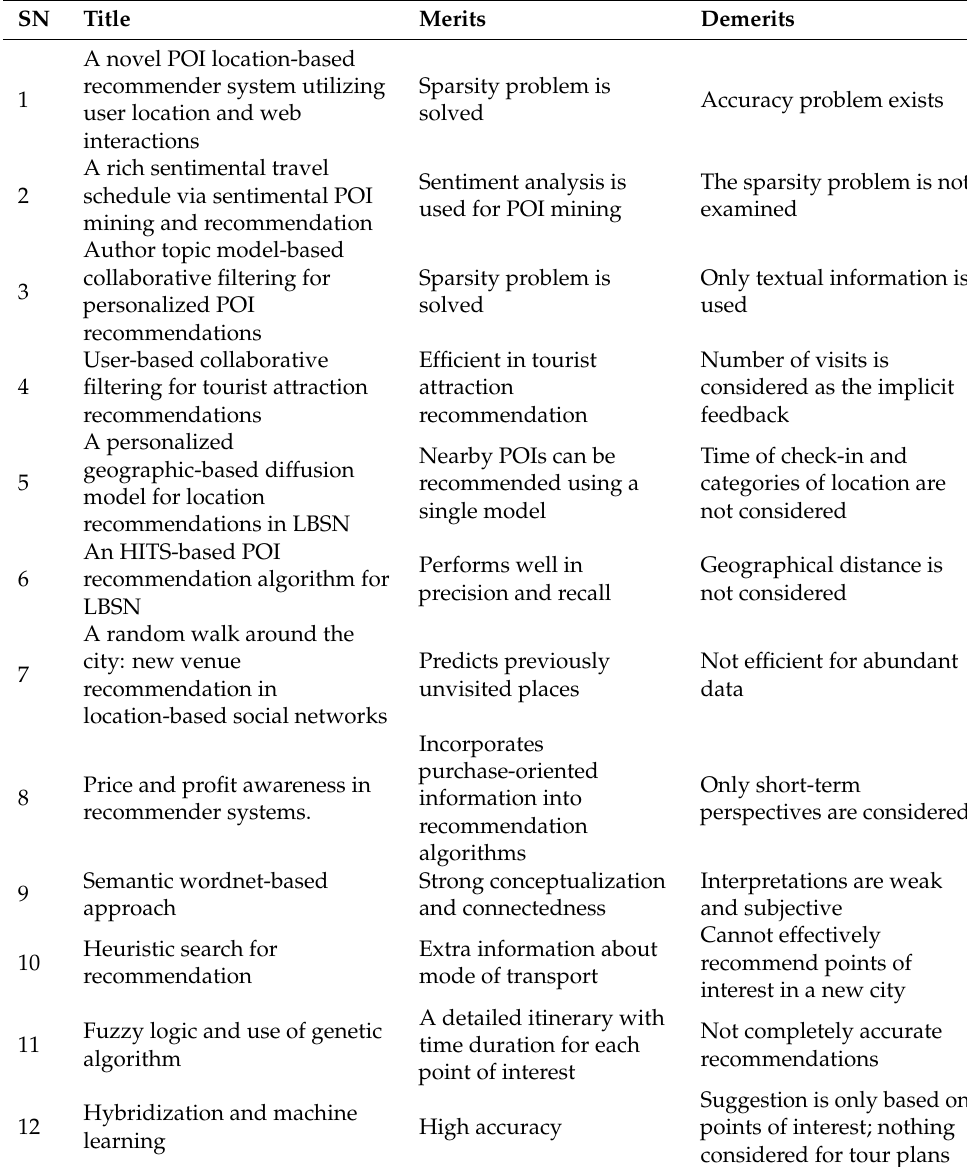
Table 1. A comparative analysis of novel studies on travel recommender